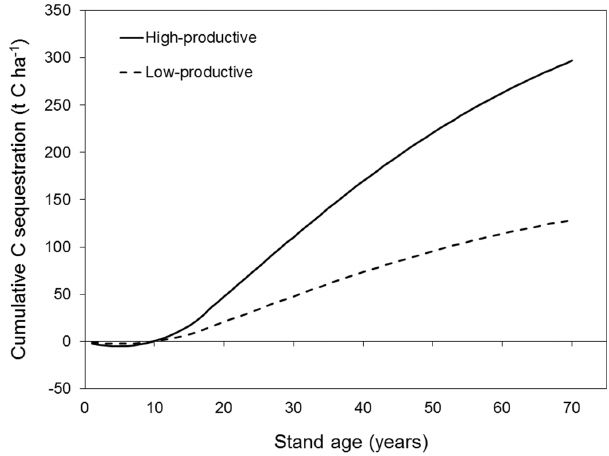
Figure 5. Cumulative C sequestration assuming high (site in- dex = 60; solid line) and low (site index = 26; dashed line) site qual- ity for all four Turkey Point pine